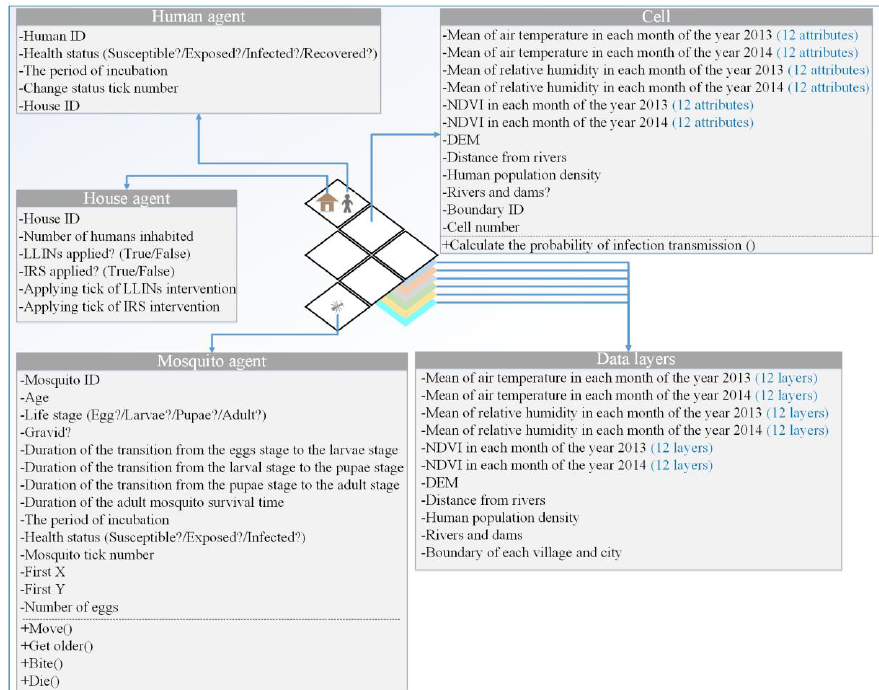
Figure 3. Parameters and settings of the agent-based model.